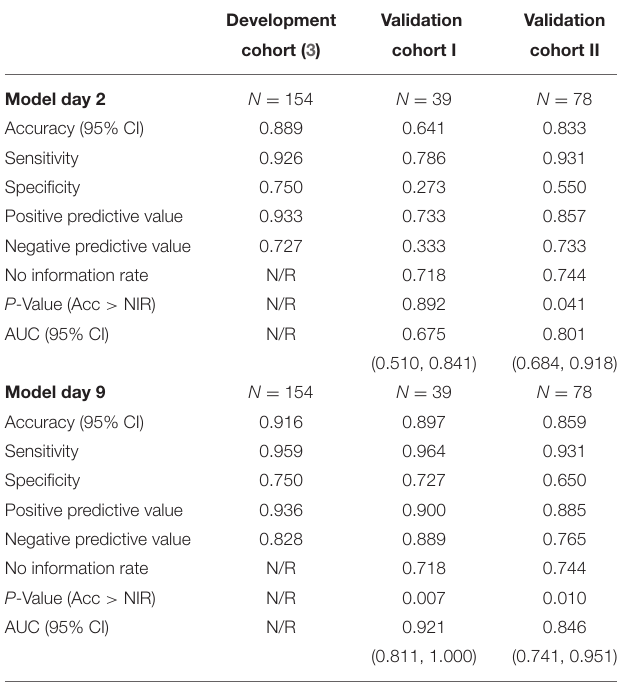
TABLE 2 | Discrimination of the Early Prediction of Functional Outcome after Stroke (EPOS) model for independent gait in the development and validation cohorts based on imputed